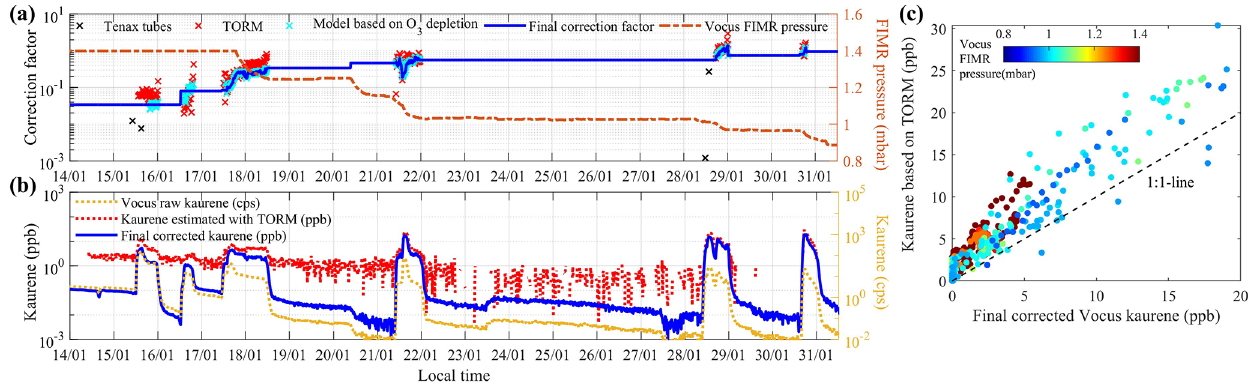
Figure 2. Correction factors and time series of kaurene. Panel (a) shows the correction factors (left axis) needed to scale the Vocus count rates to mixing ratios at varying FIMR pressures (right axis) using different methods. The black crosses represent the needed correction factors based on Tenax tube samples, the red crosses represent correction factors derived from the TORM system, and the blue crosses represent correction factors according to the O 3 depletion model (see Sect. 2.3 for details). The blue line shows the final correction factors we used in this study. Panel (b) displays the time series of the measured raw kaurene signal intensities (yellow), the kaurene concentration estimated by the O 3 reactivity system TORM (red), and the final kaurene concentration after corrections (blue). Panel (c) shows the relationship between the kaurene concentrations based on the TORM system and the final corrected Vocus kaurene